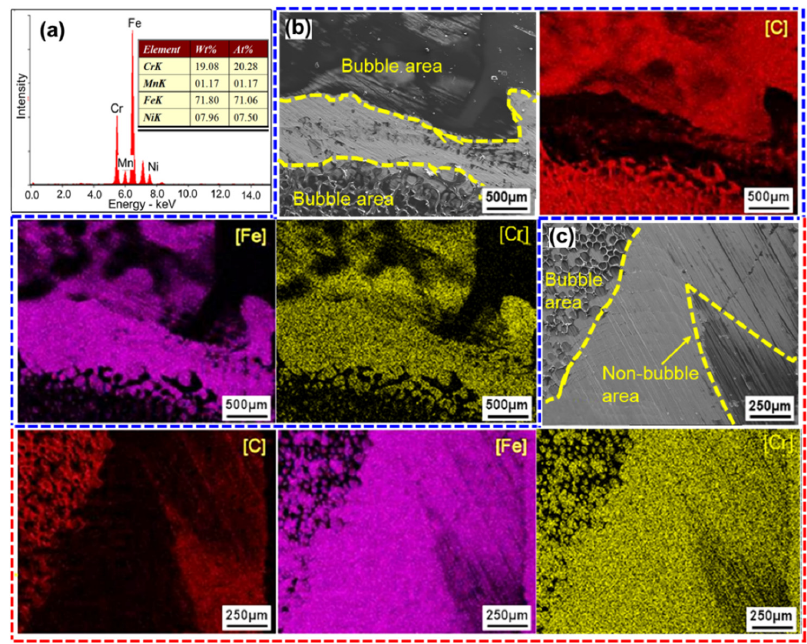
Figure 7. Chemical composition at the 304SS side of the fractured surface: ( a ) EDS of 304, ( b ) EDS mapping of LTJ, ( c ) EDS mapping of